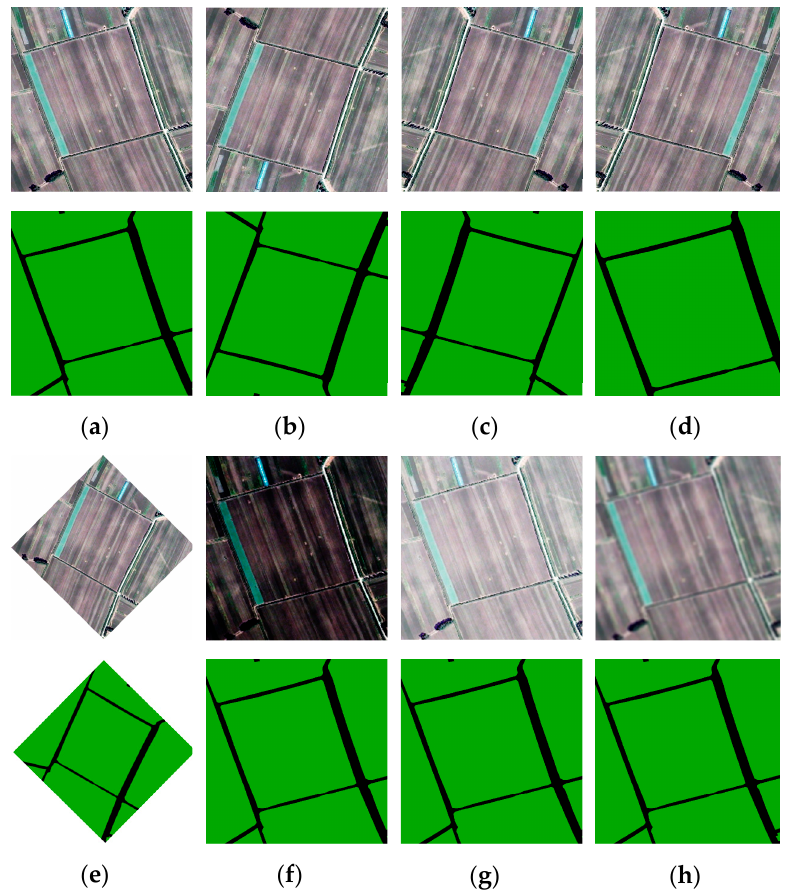
Figure 3. Sample increment result. ( a ) Original data, ( b ) fold up, ( c ) fold to the right, ( d ) zoom in 125%, ( e ) rotate clockwise by 45°, ( f ) enhance color contrast (gamma = 3.0), ( g ) reduce color contrast, and ( h ) Gaussian blur (Gaussian kernel = 0.5).